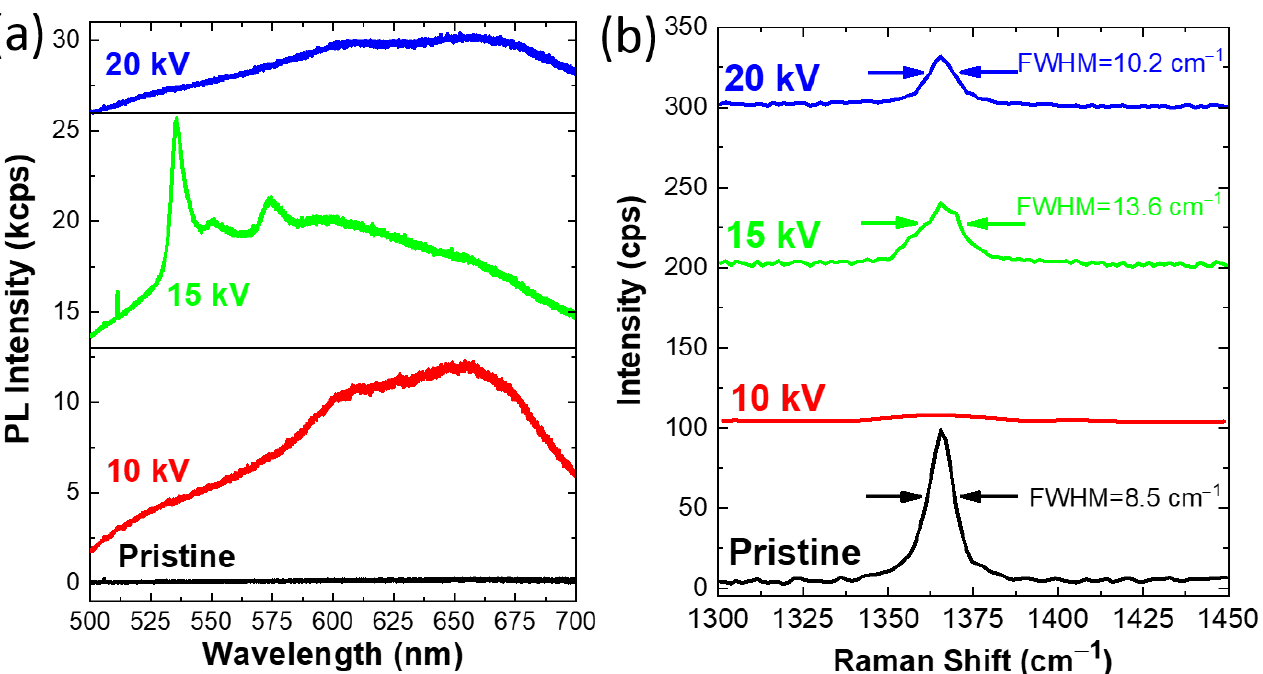
Figure 2. ( a ) PL spectra of the hBN irradiated with different electron beam energies: pristine hBN (black line), 10 keV (red line), 15 keV (green line), 20 keV (blue line) irradiation. ( b ) Raman spectra obtained in the irradiated areas. All spectra are vertically shifted for a better comparison.